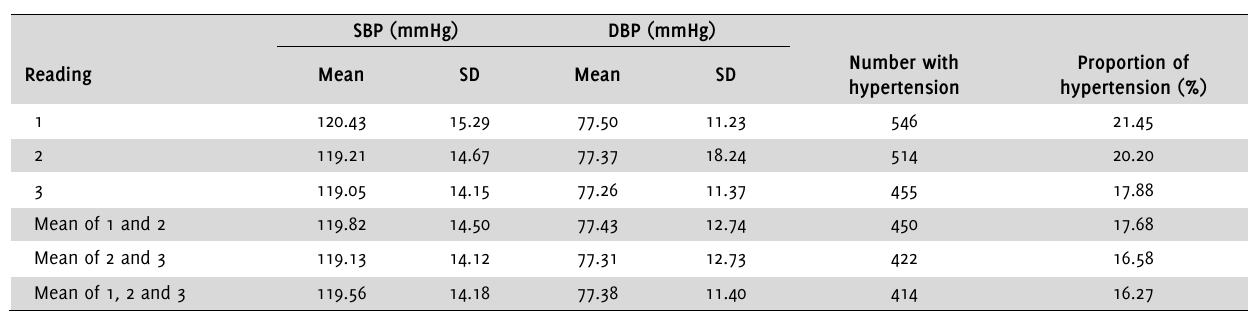
Table 4. Mean Blood Pressure by Social Gap Index, Before and After Standardization by Age and Sex.